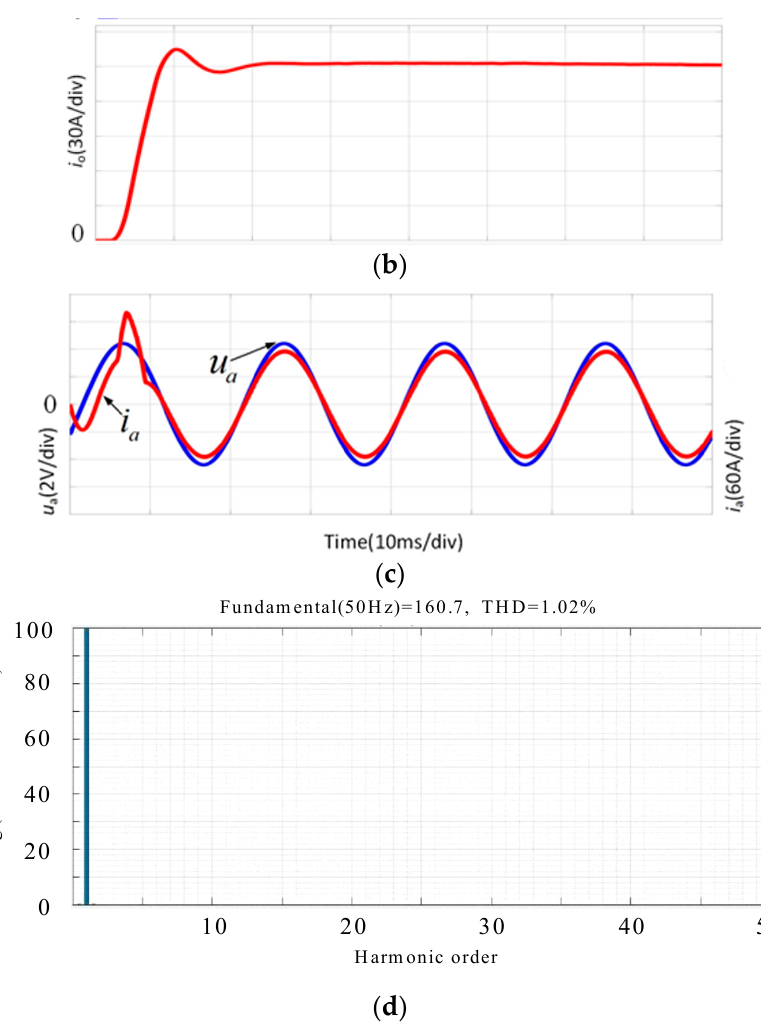
Figure 8. Simulation waves of the Lyapunov control: ( a ) Steady-state voltage wave; ( b ) steady-state current wave; ( c ) A-phase voltage and current waves; ( d ) A-phase current spectrum.